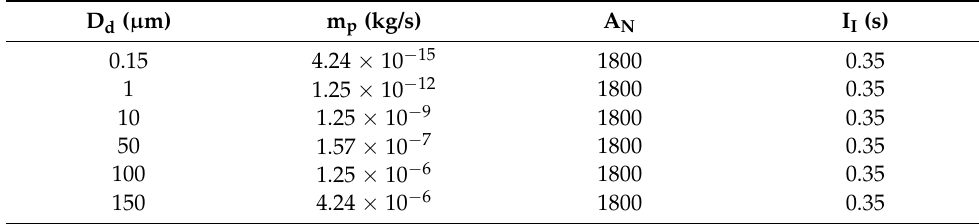
Table 2. Specification of injected droplets (COVID-19 viruses).